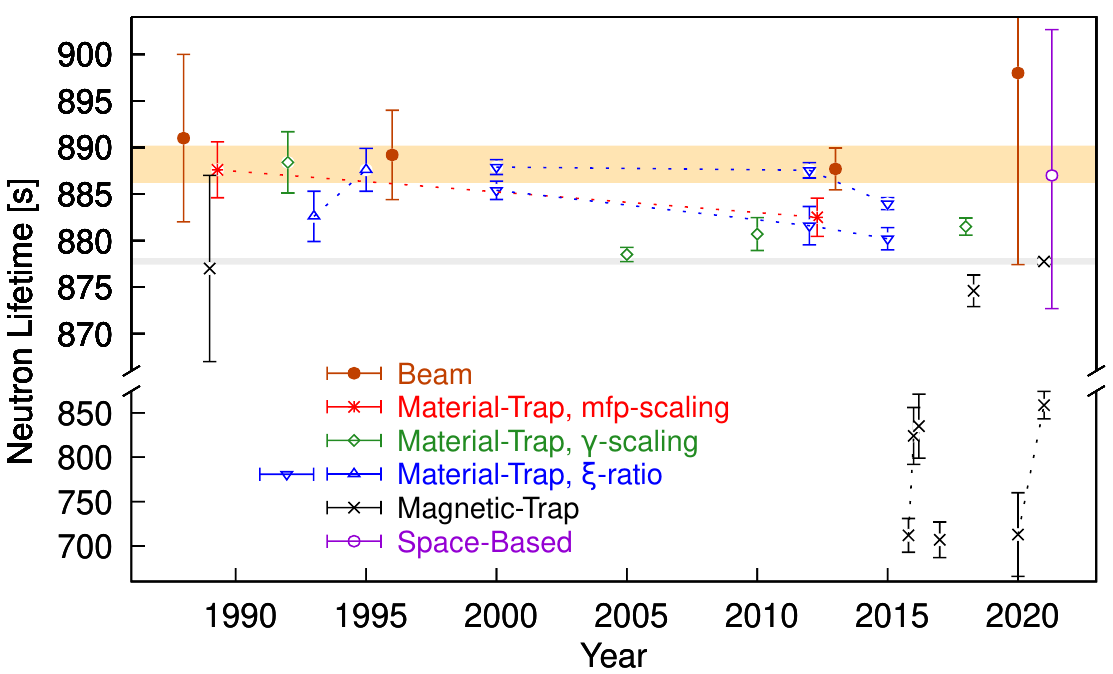
Figure 1. Results of modern neutron lifetime measurements are shown. Different techniques are presented with different symbols and colors. Correlated results from the same apparatus are connected by dashed lines. See detailed information in text and Table